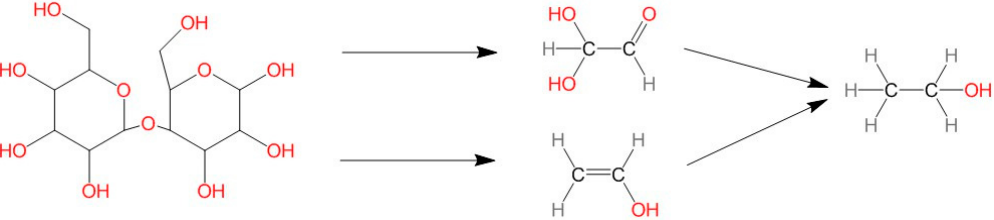
Figure 8. The curve of ethanol molecules.